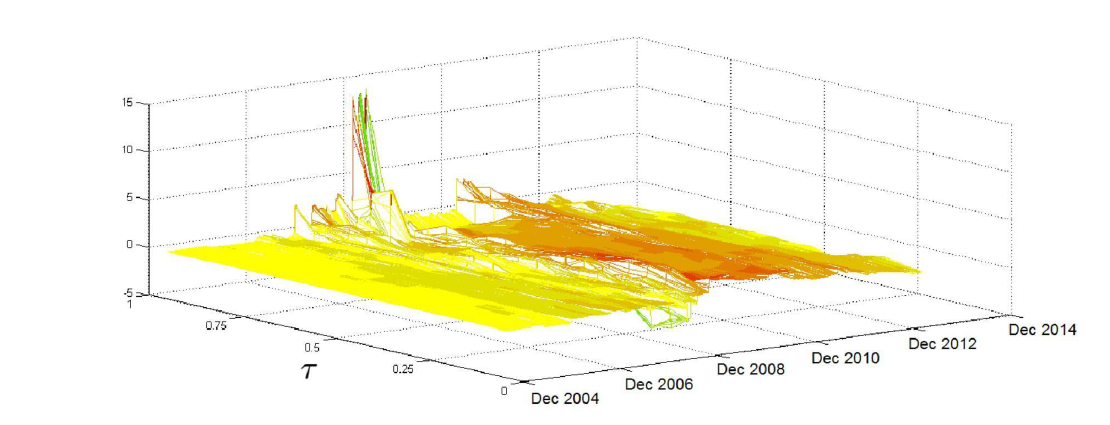
Figure 6. Rolling analysis for jump t − 1